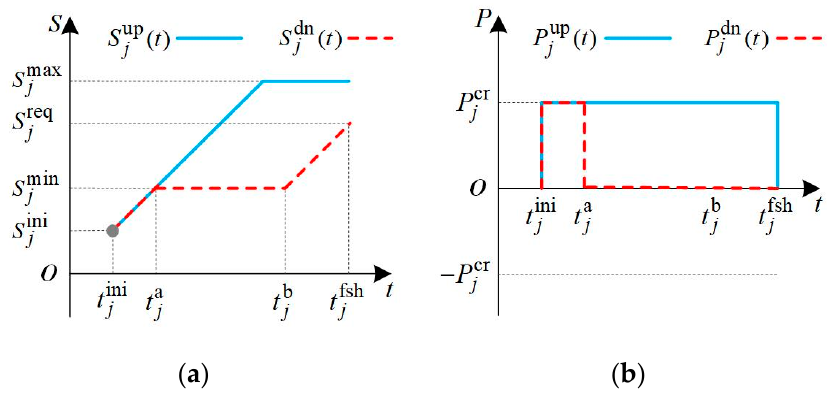
Figure 2. Regulation capacity of an EV with regulation mode 2: ( a ) SOC upper and lower boundaries; ( b ) power upper and lower boundaries.